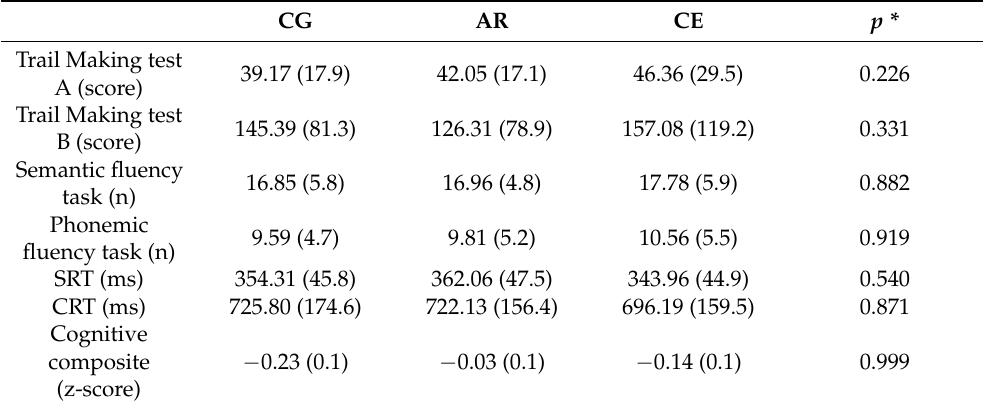
Table 2. Comparison between the cognitive tasks in the three different moments of evaluation. CG AR CE p